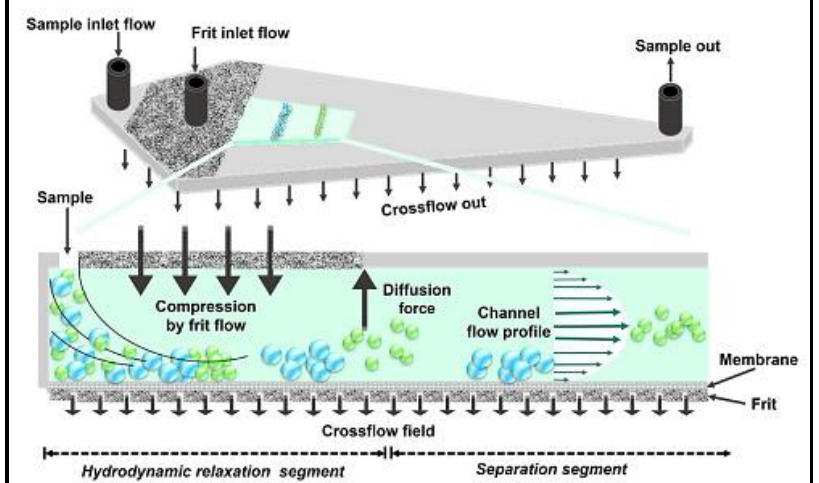
Figure 1. Schematic representation of an asymmetric flow field flow fractionation channel equipped with a frit inlet (FI-AF4). Frit inlet flow propels sample components towards the accumulation wall, allowing their hydrodynamic relaxation without stopping their axial migration. Adapted with permission from [22], Elsevier, 2021.